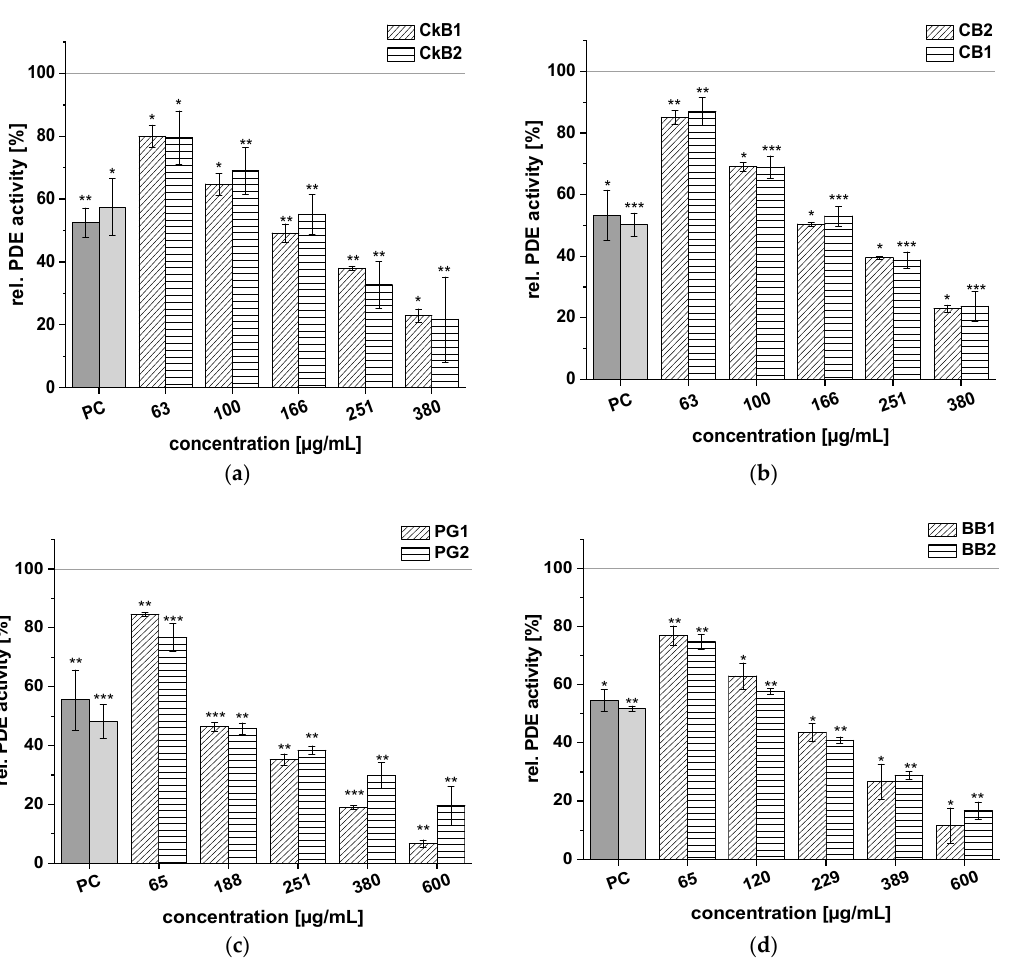
Figure 3. Results for tests of cAMP-specific phosphodiesterase (PDE) activity after incubation each with two chokeberry (CkB1, CkB2) ( a ), cranberry (CB1, CB2) ( b ), pomegranate (PG1, PG2) ( c ), and blueberry (BB1, BB2) ( d ) extracts. Positive control (PC) was caffeine (1.21 mM). Data are expressed as relative (rel.) PDE activity (in percentage of solvent control) as mean ± standard deviation of three or four independent experiments. The significance of differences between sample and solvent control (100%) was assessed using Student’s t -test. * p < 0.05; ** p < 0.01; *** p < 0.001.